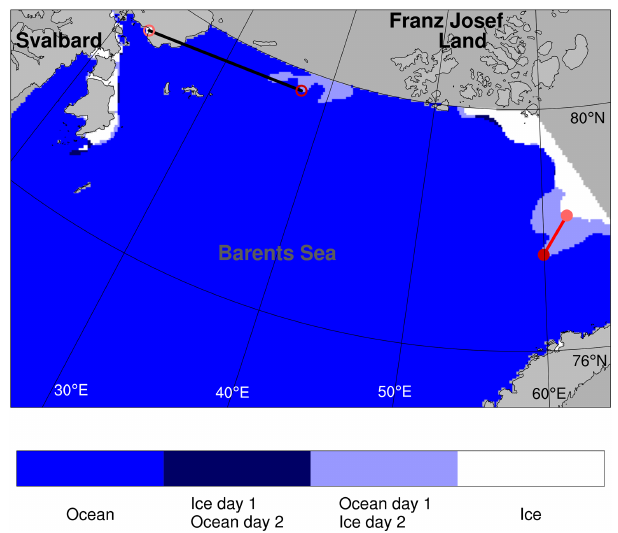
Figure 5. Sample scene displaying the changes in model sea ice extent from 23 October 2001 (day 1) to 24 October 2001 (day 2). The black line indicates the maximum displacement distance ( d (cid:49)t max , given by Eq. 5) with the original algorithm, while the red line shows the result when grid cells along the open boundaries and coastlines ˜ L(t 0 ) from Eq. B7). The color coding is given by the are included ( label bar, and note that only the northern part of the Barents Sea analysis region is